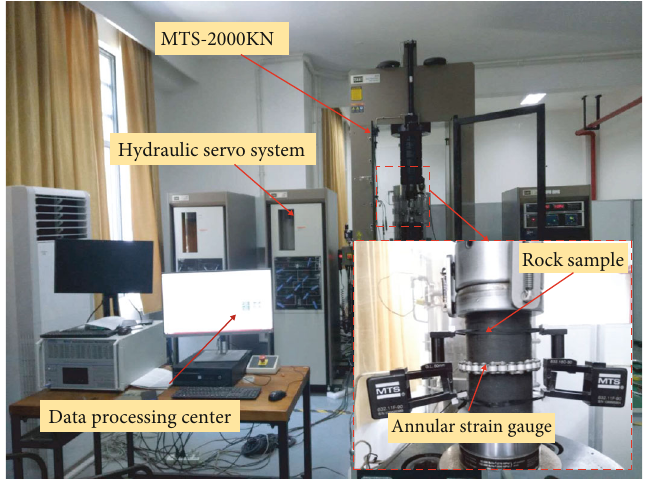
Figure 5: Rock strength testing system. Table 2: Physical and mechanical parameters of the surrounding rock.